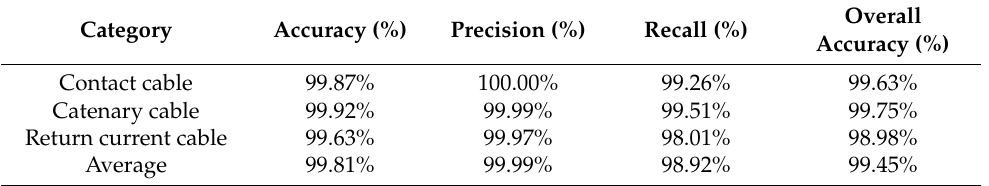
Table 6. Accuracy evaluation index for the 100 m OCS point cloud classification results by Terrasolid.